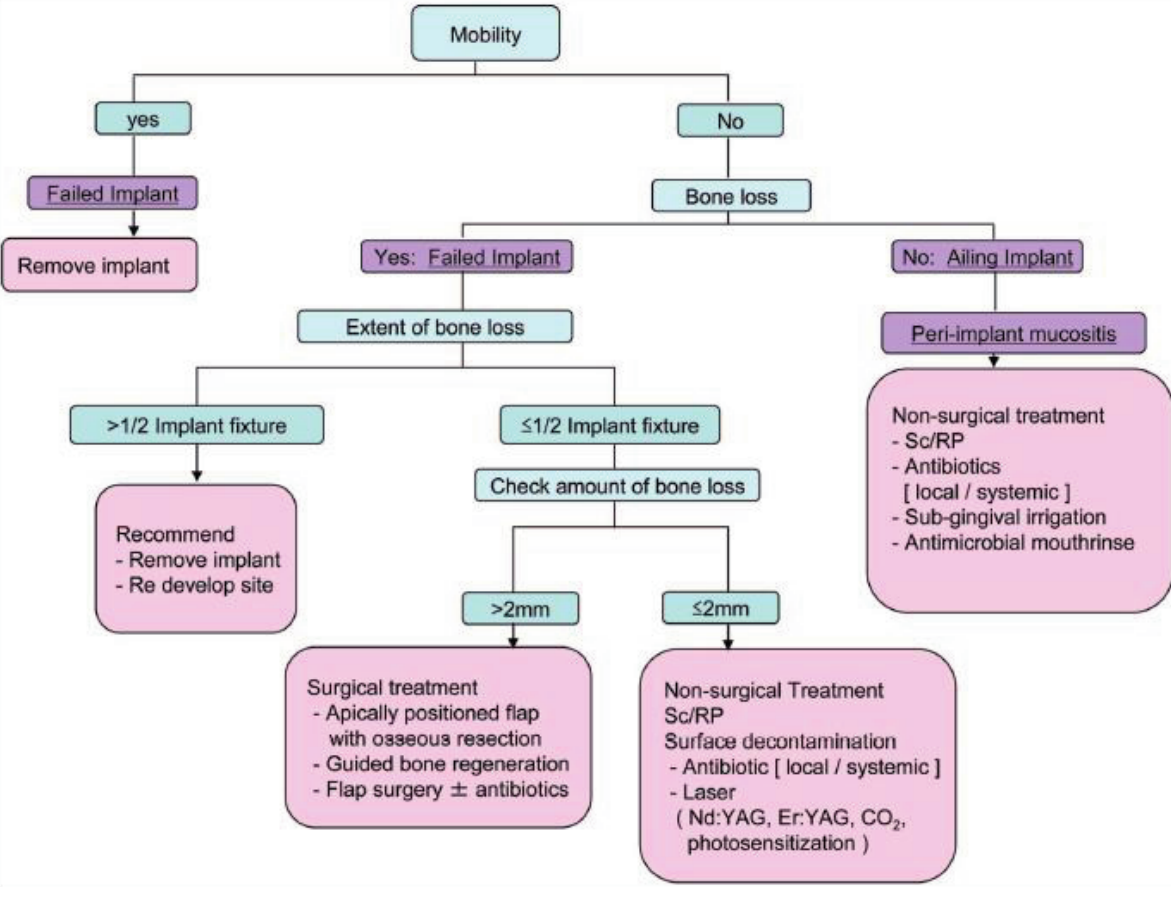
Figure 1 - Decision tree for the management of peri-implant diseases [Figure published in: Okayasu K, Wang LH. Decision Figure published in: Okayasu K, Wang LH. Decision tree for the management of tree for the management of peri-implant diseases. Implant Dent. 2012 Jun, 21 diseases periimplant. Implant Dent. 2012 Jun, 21 (3):253.